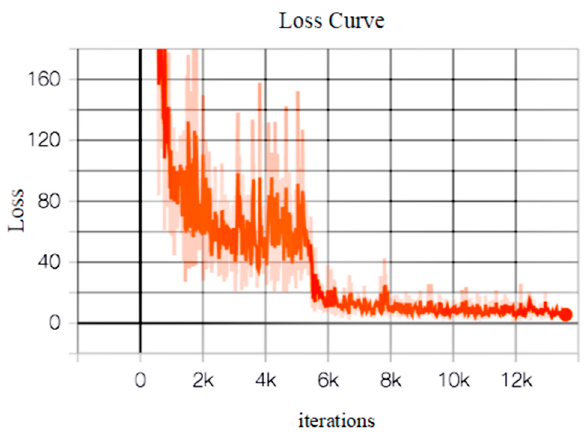
Figure 9. The training loss function graph of improved model on the MyPlane dataset.